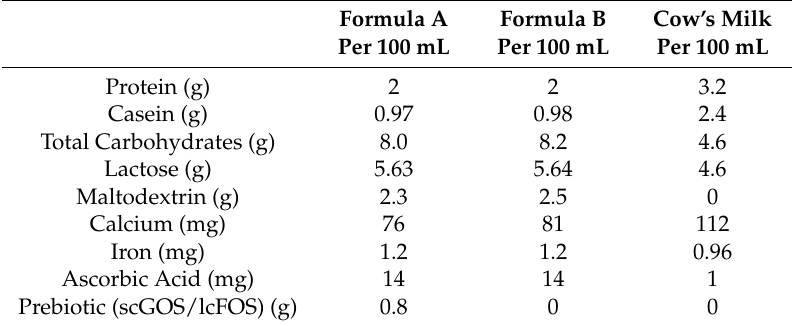
Table 1. Chemical composition of the test